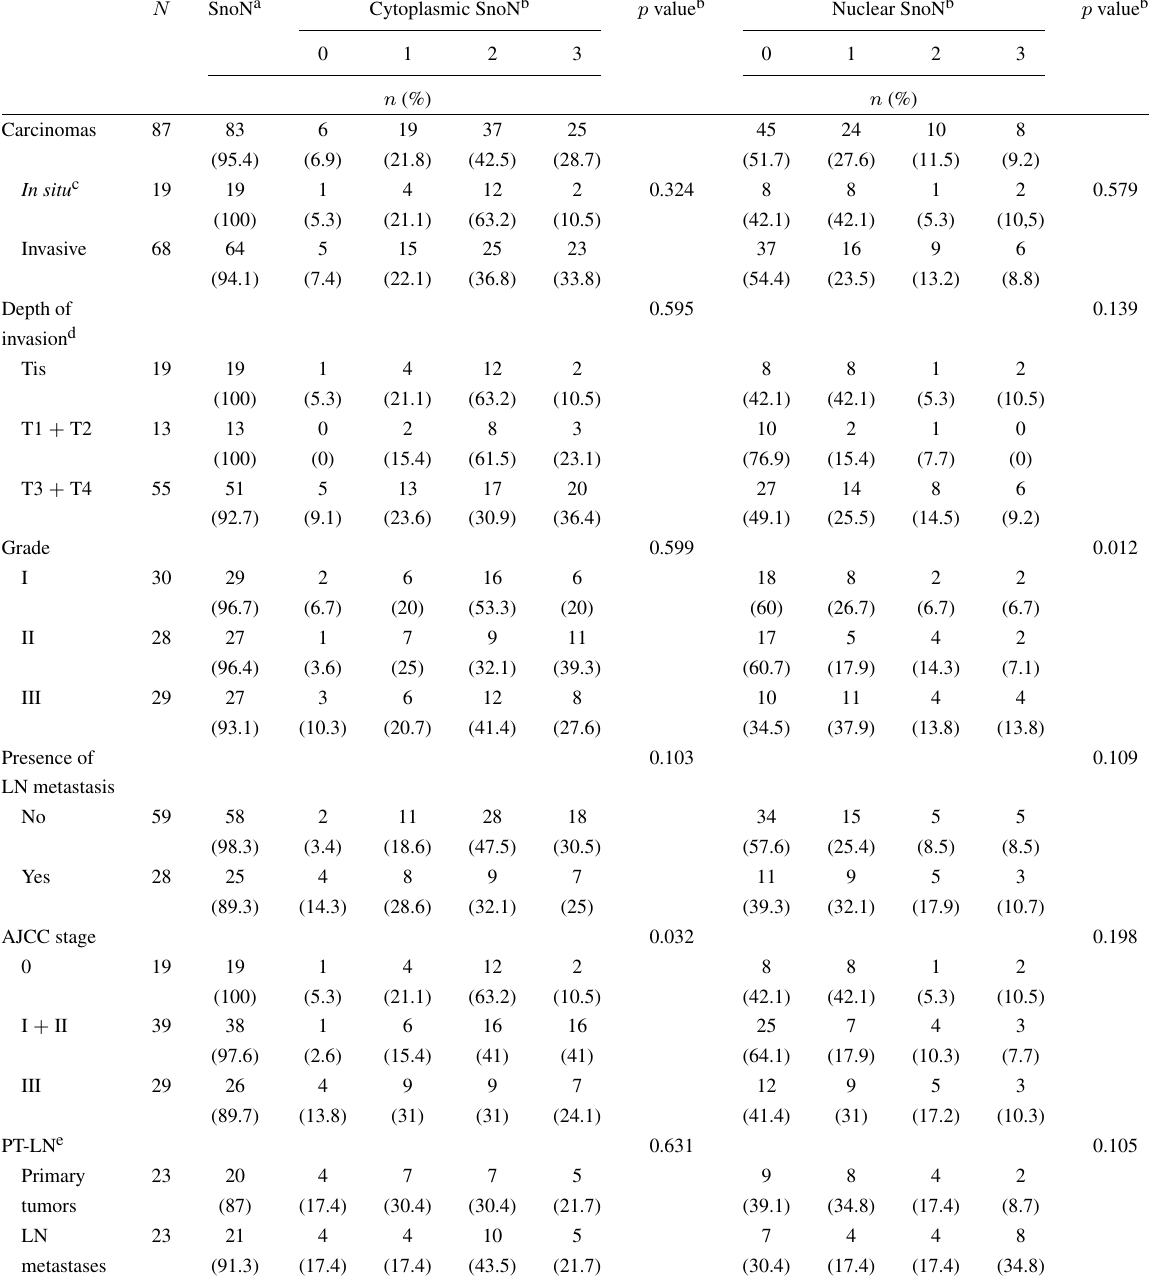
SnoN expression in human colorectal carcinomas and lymph node metastases. Correlation with clinicopathological